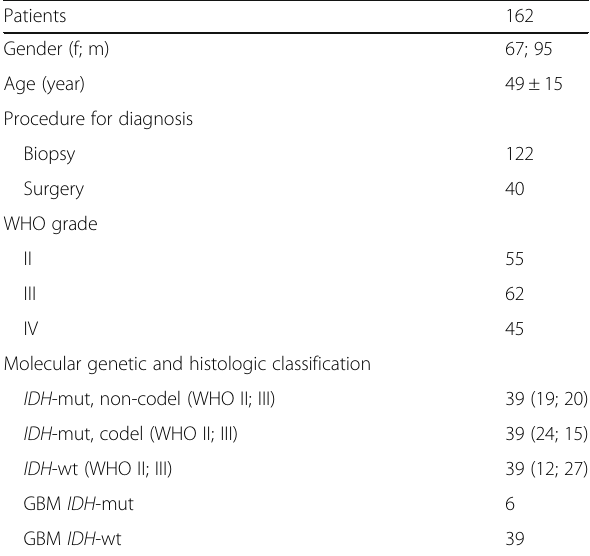
Table 1 Patient characteristics Patients